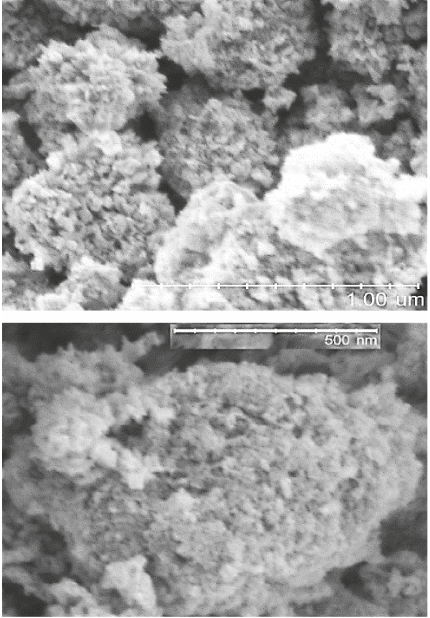
fi lm after sintering. The TiO 2 2 and BR-TiO were, respectively, 2 2